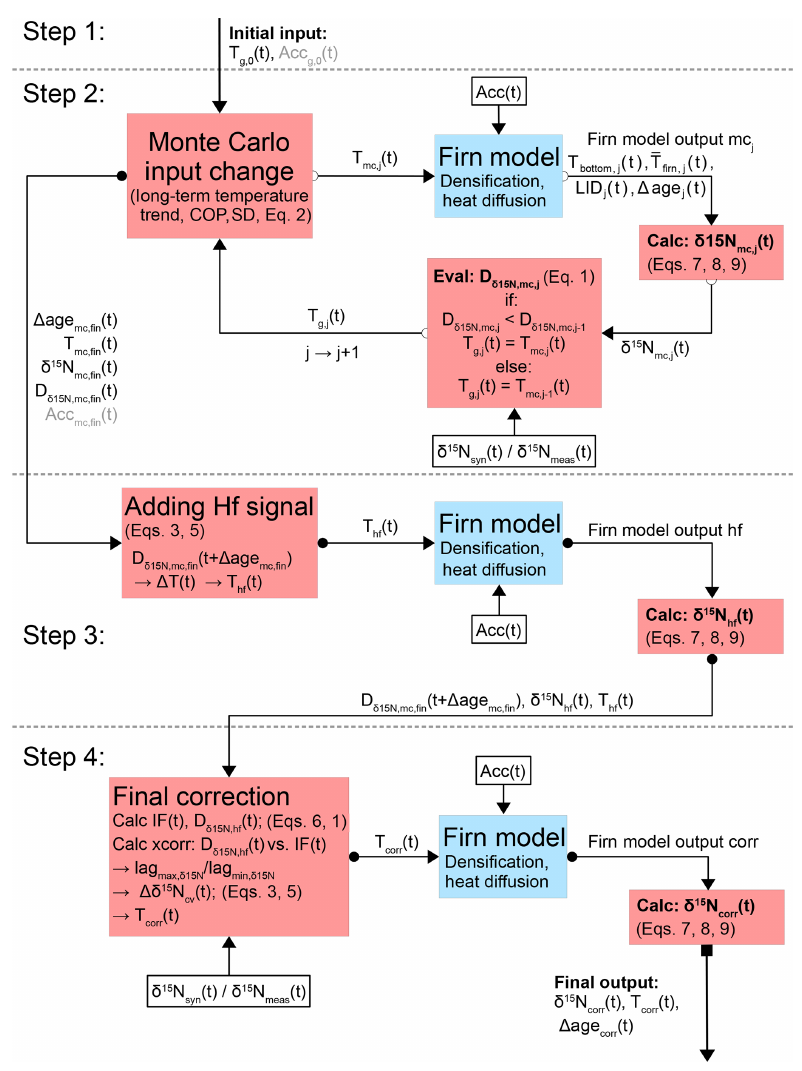
Figure 1. Schematic illustration of the presented gas-isotope fitting algorithm. The algorithm is implemented in four steps: step 1: first-guess input calculation; step 2: iteratively Monte Carlo based input change (indicated by the open half cycles); step 3: signal complementation with high-frequency information; step 4: final correction. In contrast to the synthetic data study on Holocene-like data where the accumulation input Acc( t ) was fixed, for the proof of concept on glacial data, the accumulation and temperature input was iteratively changed in parallel indicated by the grey variables Acc g , 0 and Acc mc , fin . For the glacial study, only steps 1 and 2 were